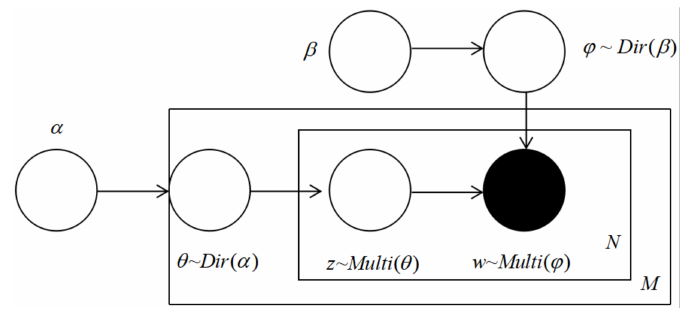
Figure 3. Schematic diagram of LDA model